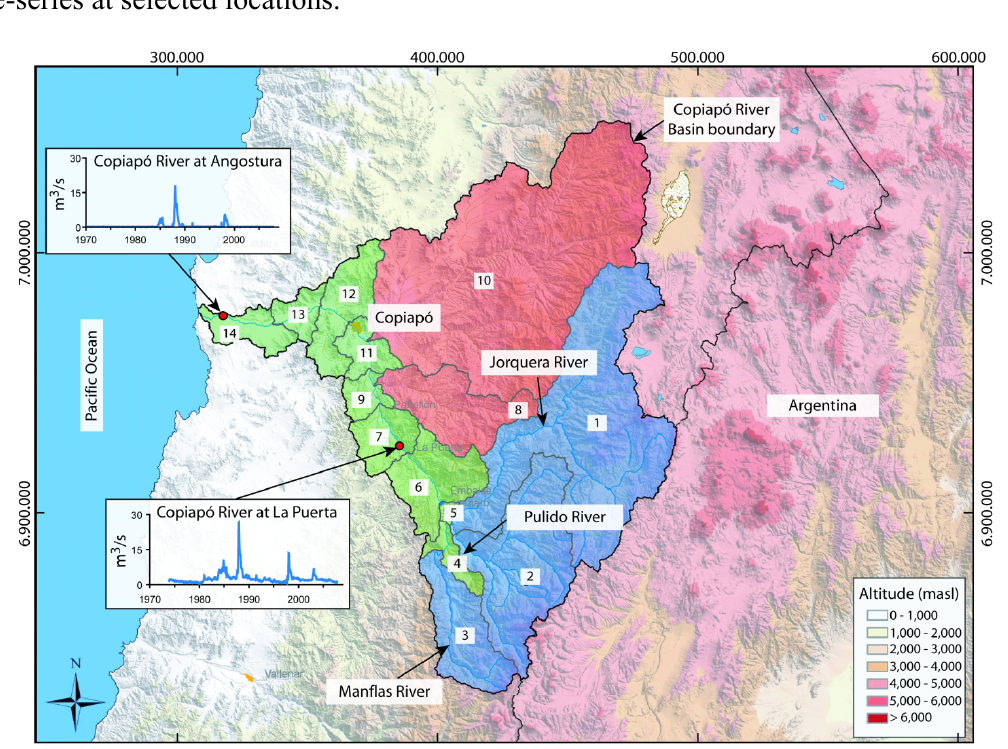
Figure 1. The Copiapó River basin: its drainage network and sub-basins, and water flow time-series at selected